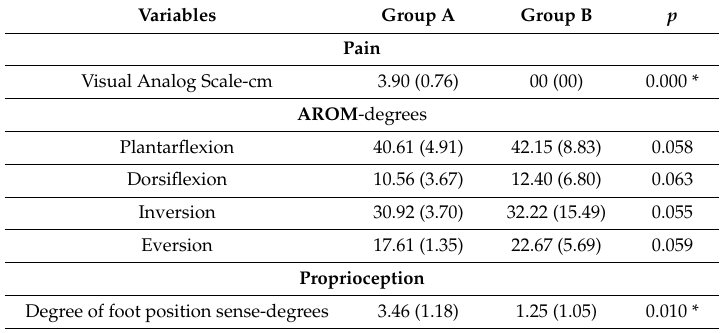
Table 2. Comparison of pain, active range of motion (AROM), and proprioception between the groups: Mean (SD).